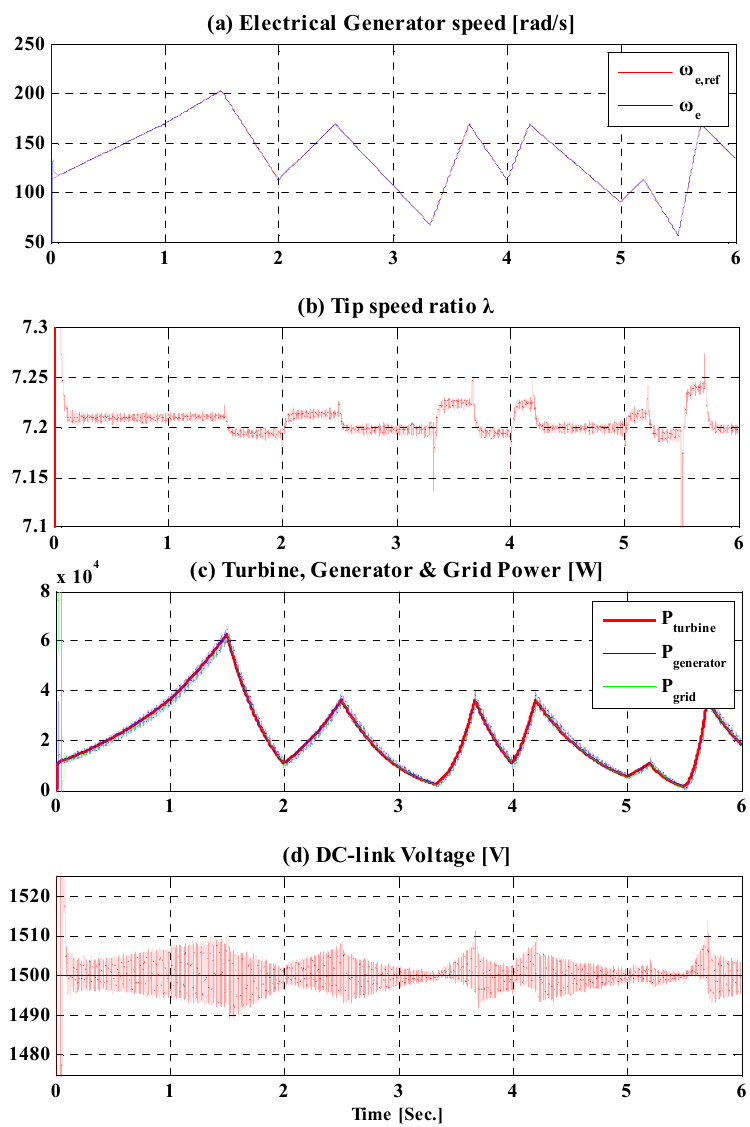
Figure 5. Simulation results of the wind turbine system: ( a ) electrical speed of synchronous generator; ( b ) tip speed ratio of the wind turbine; ( c ) output power of the turbine, generator and grid-side converter; and ( d ) dc-link